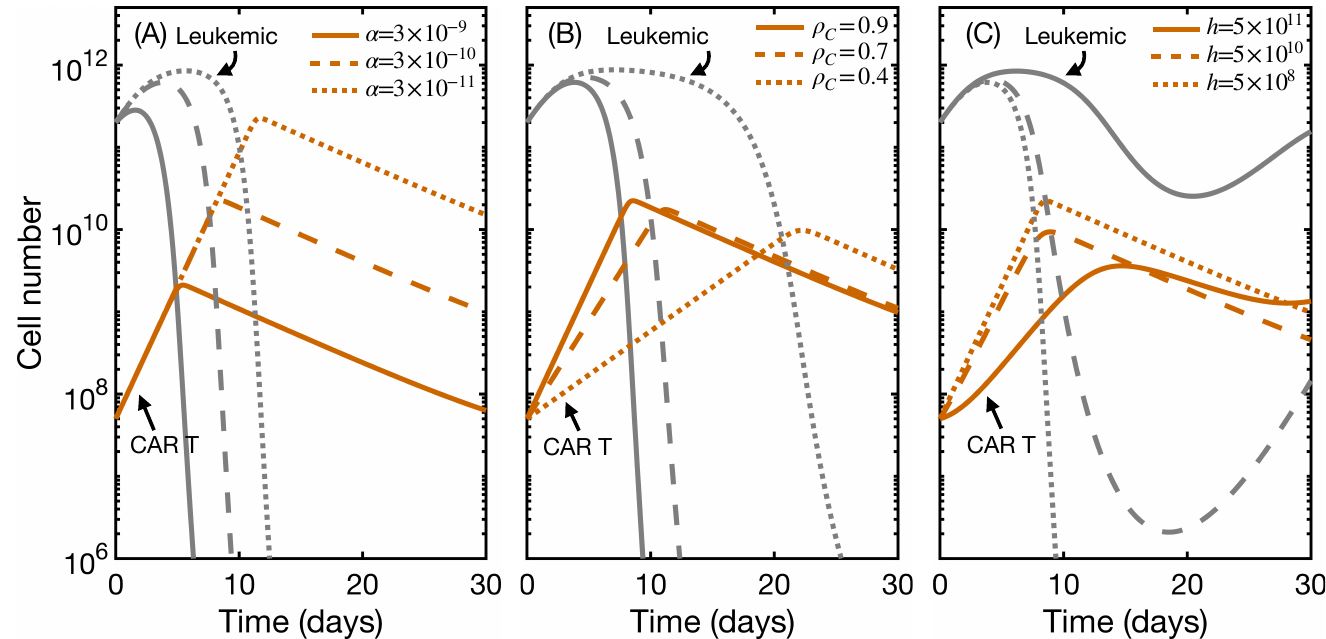
Figure 5. Influence of CAR T product characteristics. Evolution in time of leukemic cells (gray) and total CAR T-cells (orange) for different CAR T product attributes (In decreasing order: solid, dashed, dotted lines). Initial state is B 0 ( 0 ) = 10 6 cells, B 1 ( 0 ) = 3 × 10 7 cells, B 2 ( 0 ) = 2 × 10 8 cells, B 3 ( 0 ) = 9 × 10 7 cells, L ( 0 ) = 2 × 10 11 cells, C A ( 0 ) = 5 × 10 7 cells and C M ( 0 ) = 0 cells. The remaining parameter values are those of Table 1 with α = 3 × 10 − 10 day − 1 · cell − 1 and h = 5 × 10 8 cells. ( A ) influence of killing capacity; ( B ) influence of proliferation rate; ( C ) influence of activation